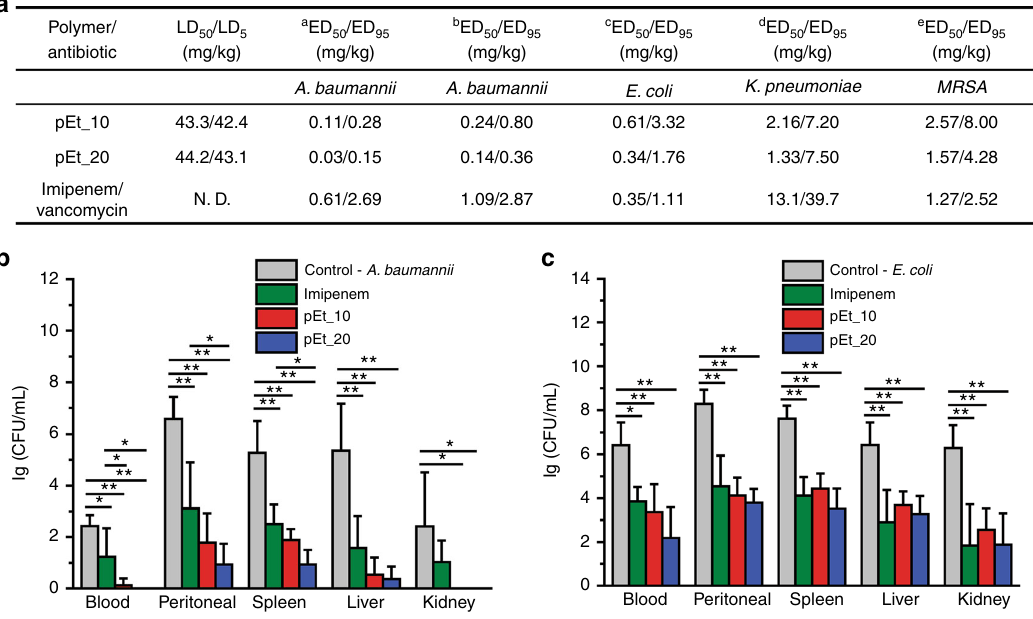
Fig. 6 In vivo antibacterial ef fi cacy in various infectious mouse models. a ED 50 and ED 100 of polymers and the imipenem or vancomycin control (a: MDR A . baumannii 10073-caused peritonitis mouse model, intraperitoneal (i.p.) injection at 1 h and 6 h post infection; b: MDR A . baumannii 10073-caused peritonitis mouse model, i.p. injection at 3 h and 8 h post infection; c: MDR E . coli 56809-caused peritonitis mouse model, i.p. injection at 1 h and 6 h post infection; d: MDR K . pneumoniae 8637-caused peritonitis mouse model, i.p. injection at 1 h and 6 h post infection; e: MDR MRSA 25312-induced peritonitis